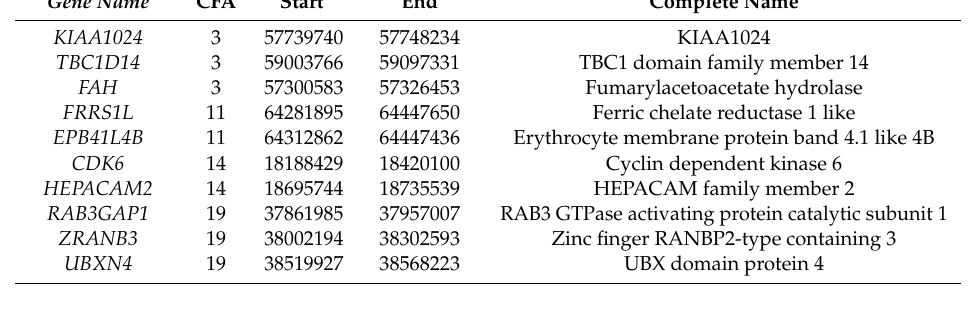
Table 2. ConsensusgenescommontotheF ST andXP-EHHanalyses: namesandchromosomalcoordinates.